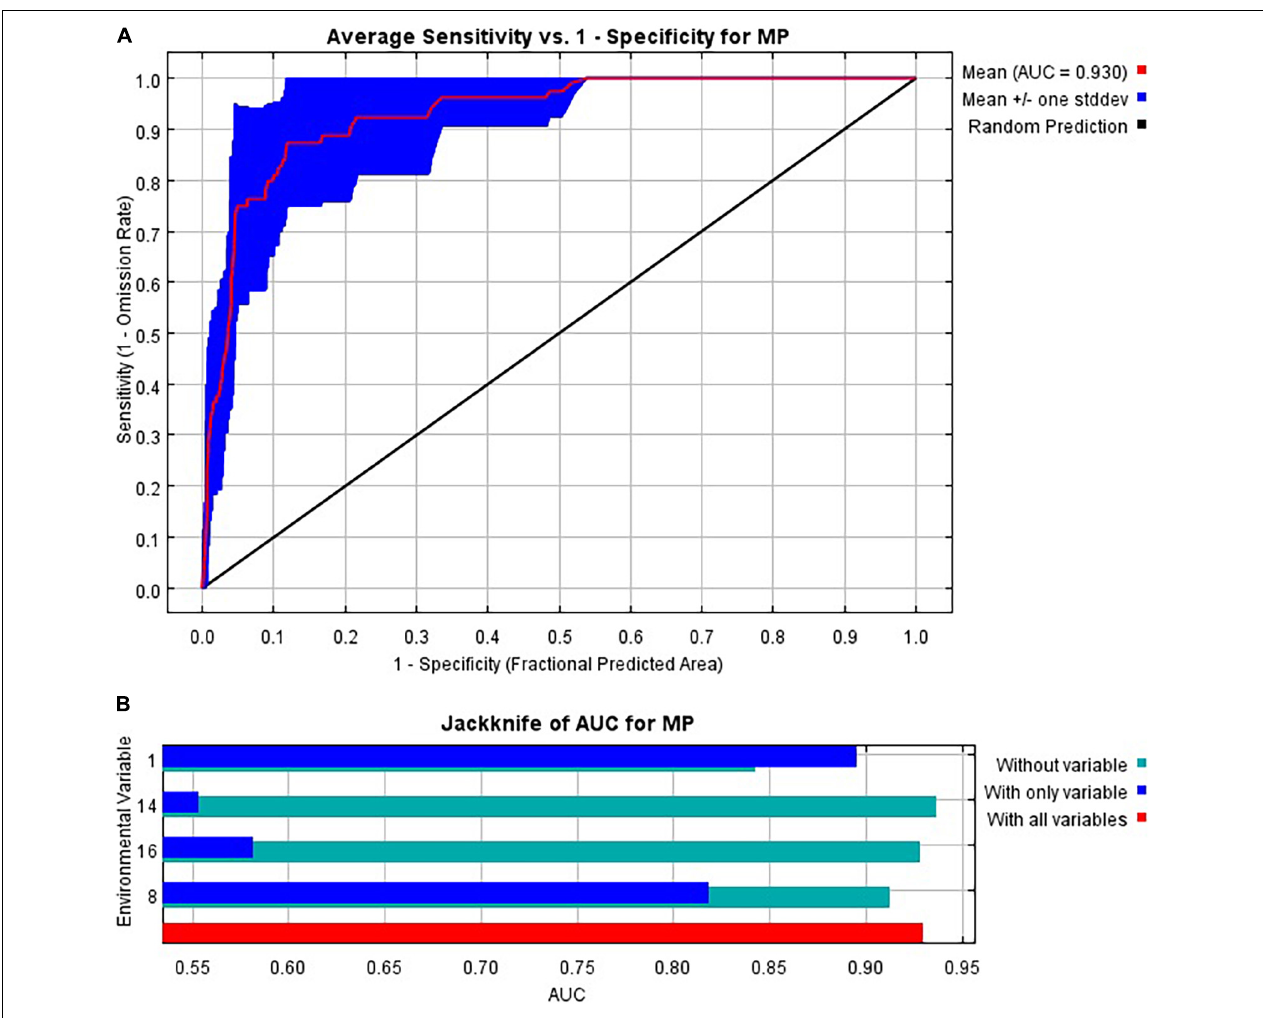
FIGURE 2 | MaxEnt model performance and variable contributions for a predictive model of the global distribution of Carpomya pardalina. (A) Receiver operating characteristic (ROC) curve averaged over the replicate runs; (B) Jackknife test of variable importance averaged over the replicate